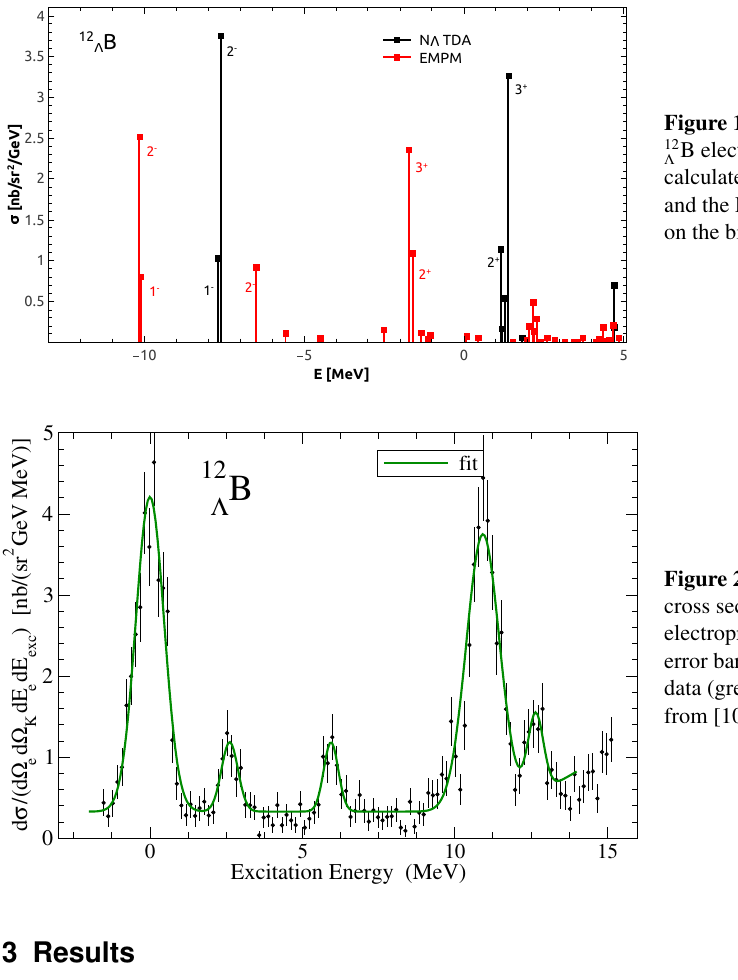
Figure 2. Experimental cross sections of 12 Λ B electroproduction (dots with error bars) and fi t of these data (green line). Taken from